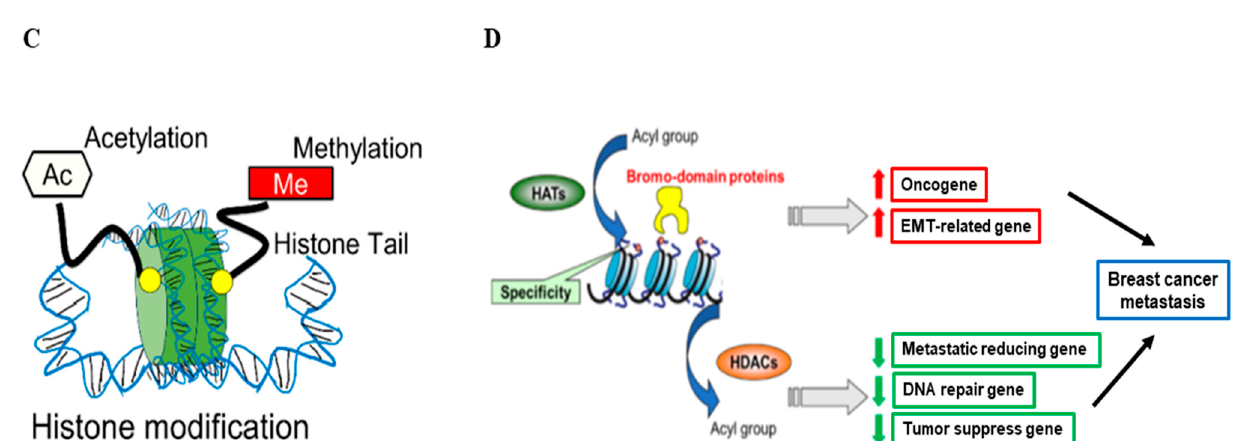
Figure 2. Epigenetic regulation in breast cancer. ( A ) The schematic process of DNA methylation. DNA methylation is mediated by DNA methyltransferases (DNMTs) (Figure modified from [54]). ( B ) Hypermethylation and hypomethylation in breast cancer. In normal epithelial breast cells, tumor suppressor genes are active and unmethylated, while genes required for metastasis are methylated and inactive. Activation of oncogenic pathways leads to the interaction of specific repressors with certain tumor suppressors leading to chromatin inactivation and DNA methylation (Figure reprinted/adapted with permission from Ref. [57]. Copyright 2004 Elsevier Inc.). ( C ) The